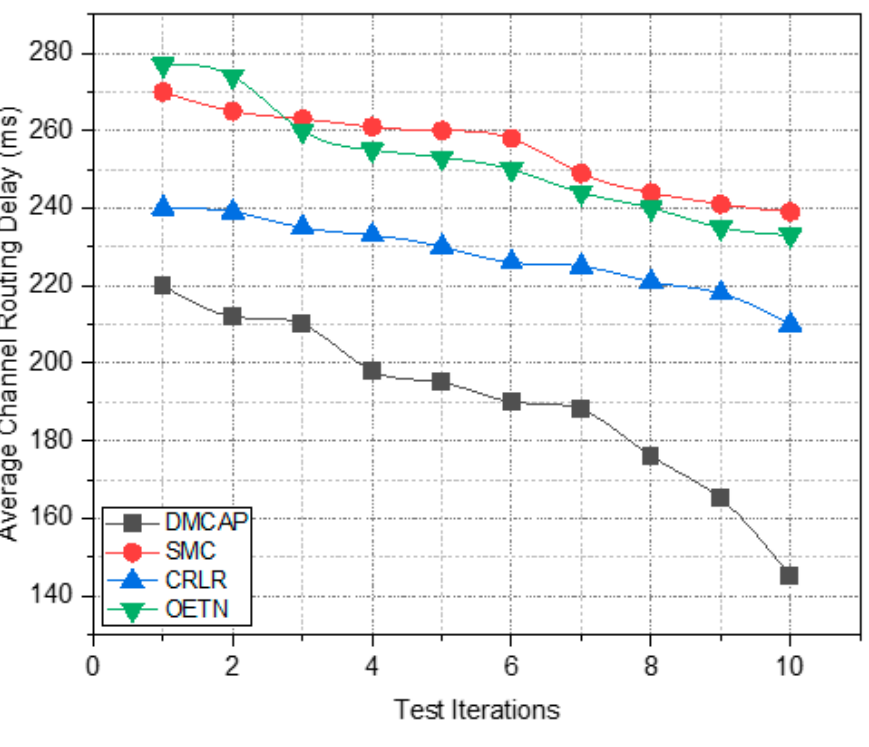
Figure 10. Average routing delay.